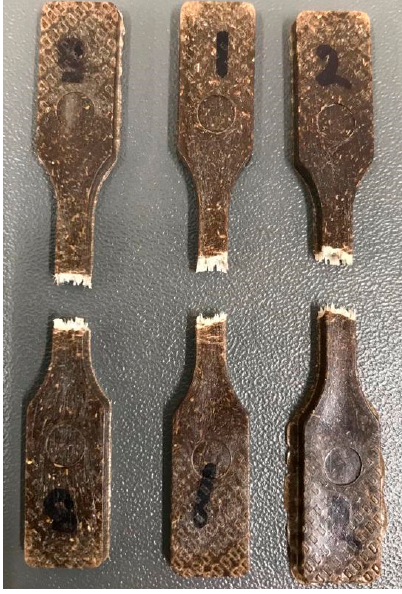
Figure 3. Tensile-broken specimens corresponding to PP/WF-5901, PP/WF-5951, and PP/WF-0218 composites.